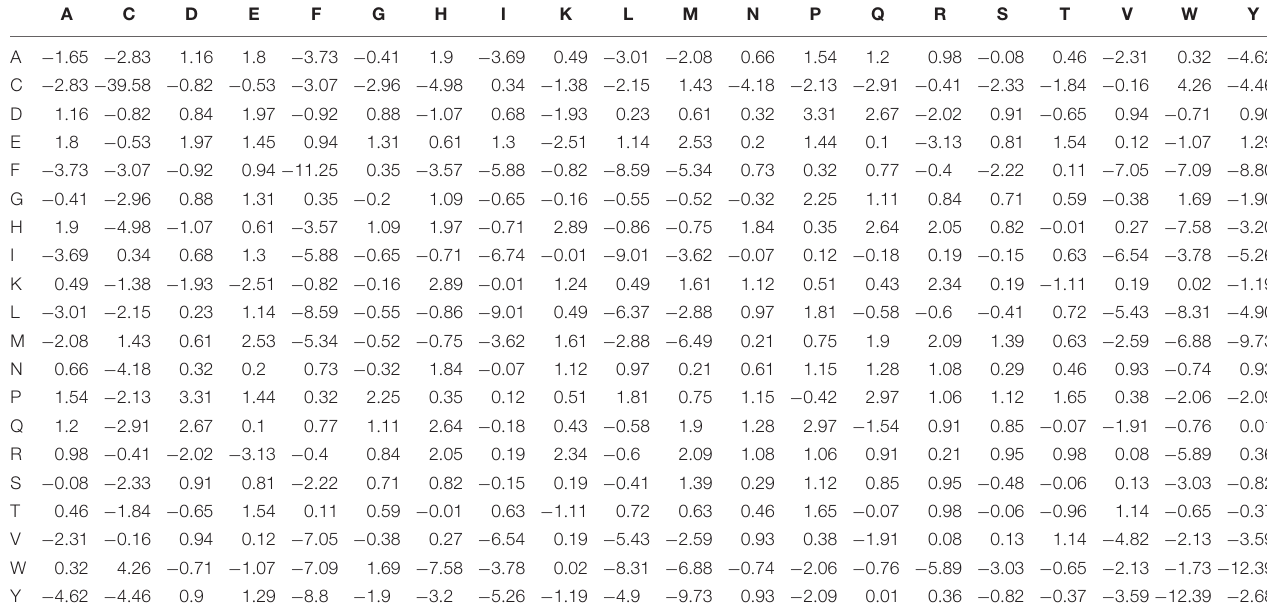
TABLE 1 | The residue pairwise energy content matrices (RECM).